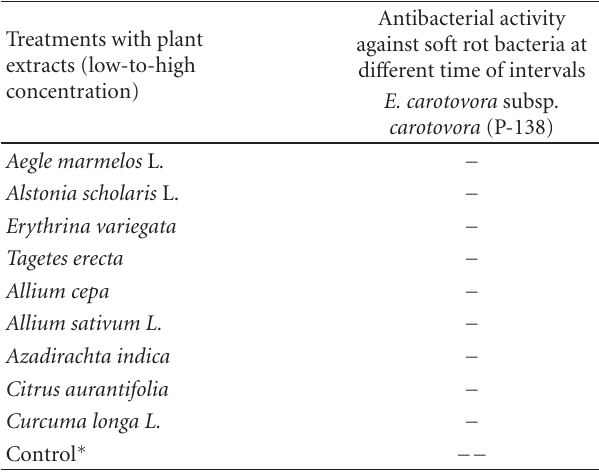
Table 3: In vitro evaluation of antibacterial activity of nineplant extracts against soft rot bacteria of